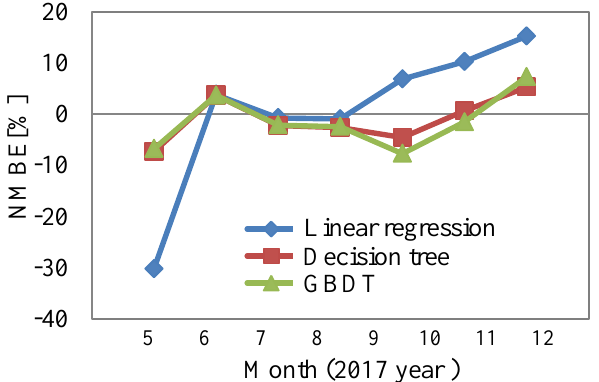
Figure 12. Transition of NMBE for each method per month.